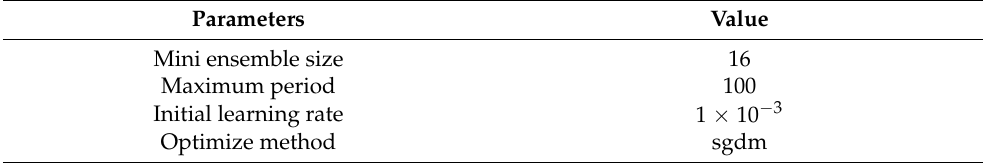
Table 5. Training parameters used in CNN models.